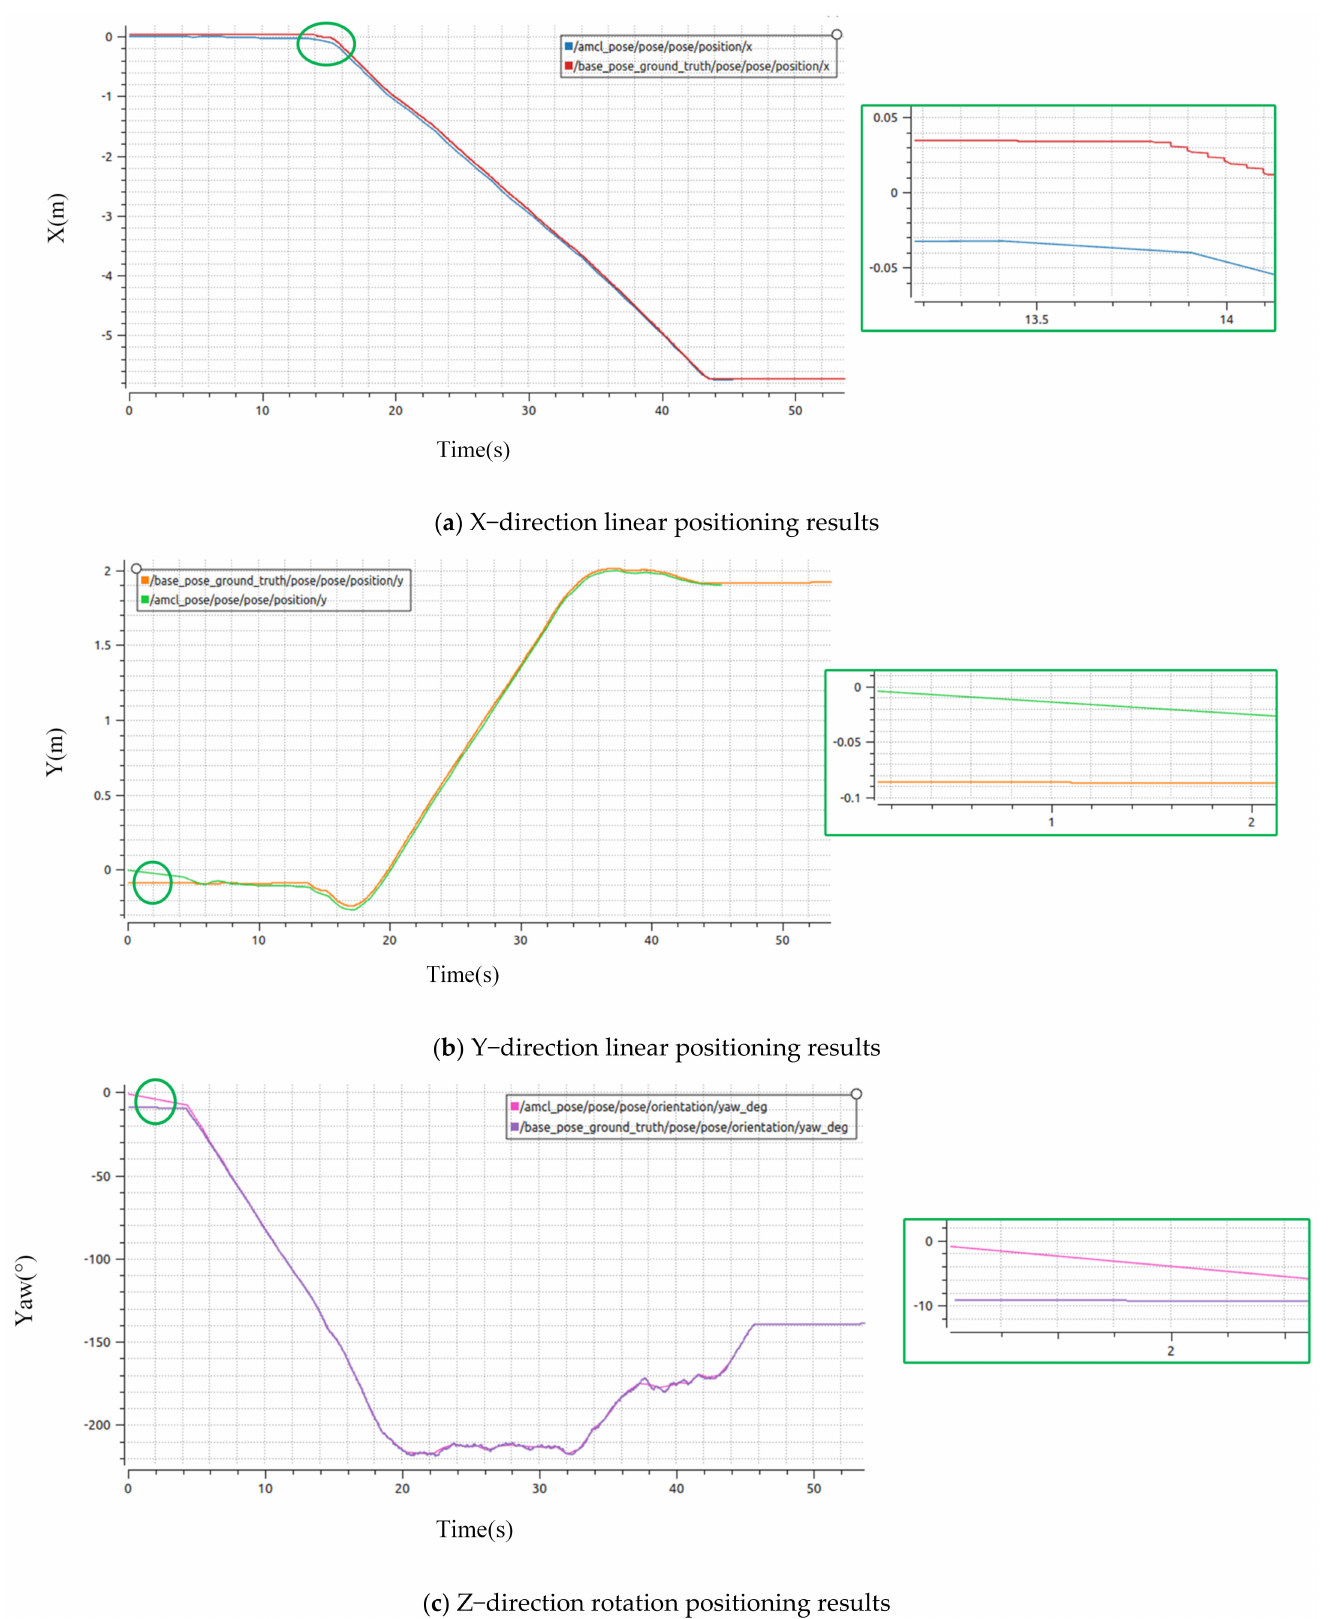
Figure 7. Results of the second group of AMCL simulation positioning